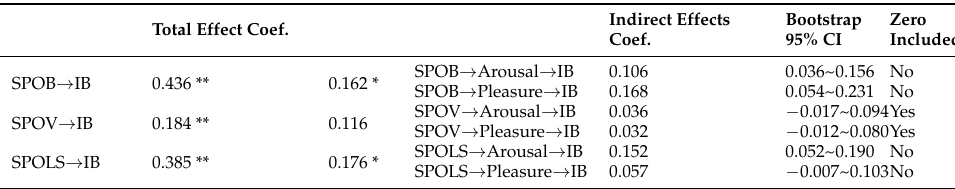
Table 6. Indirect effect results. Total Effect Coef. Indirect Effects